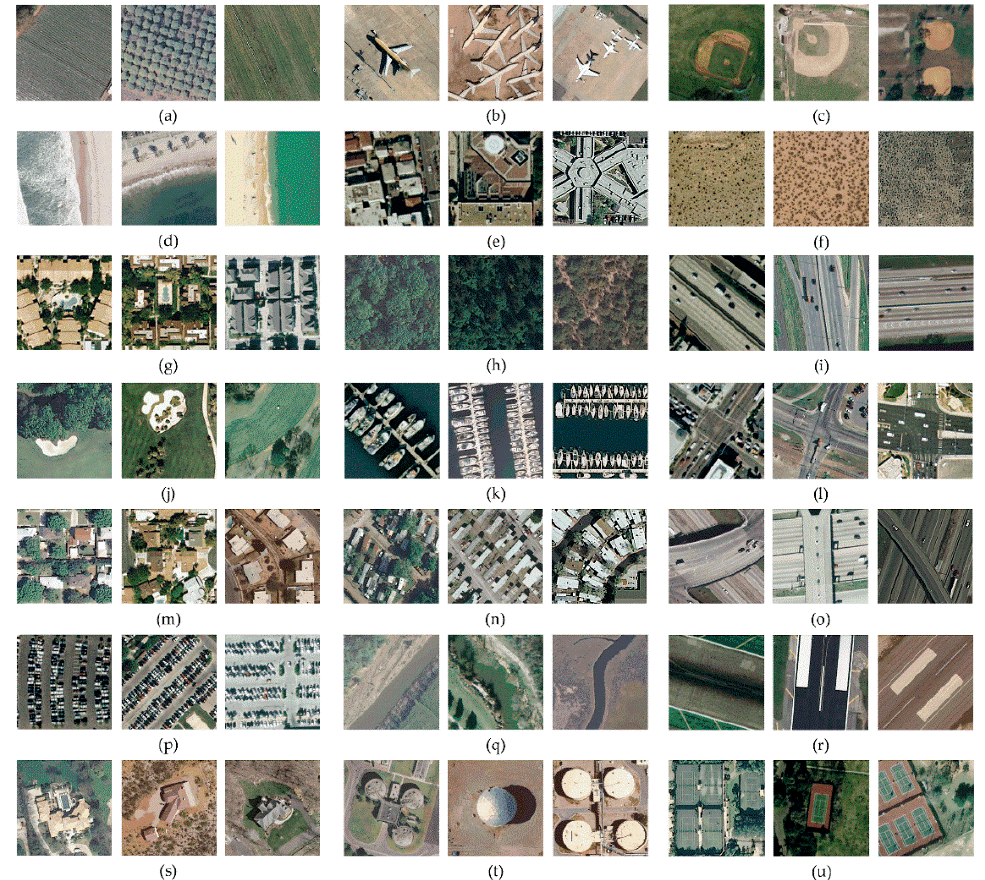
Figure 4. Sample images from each of the 21 categories in the Land Use (LU) database: ( a ) agricultural; ( b ) airplane; ( c ) baseball diamond; ( d ) beach; ( e ) buildings; ( f ) chaparral; ( g ) dense residential; ( h ) forest; ( i ) freeway; ( j ) golf course; ( k ) harbor; ( l ) intersection; ( m ) medium density residential; ( n ) mobile home park; ( o ) overpass; ( p ) parking lot; ( q ) river; ( r ) runway; ( s ) sparse residential; ( t ) storage tanks; ( u ) tennis courts.